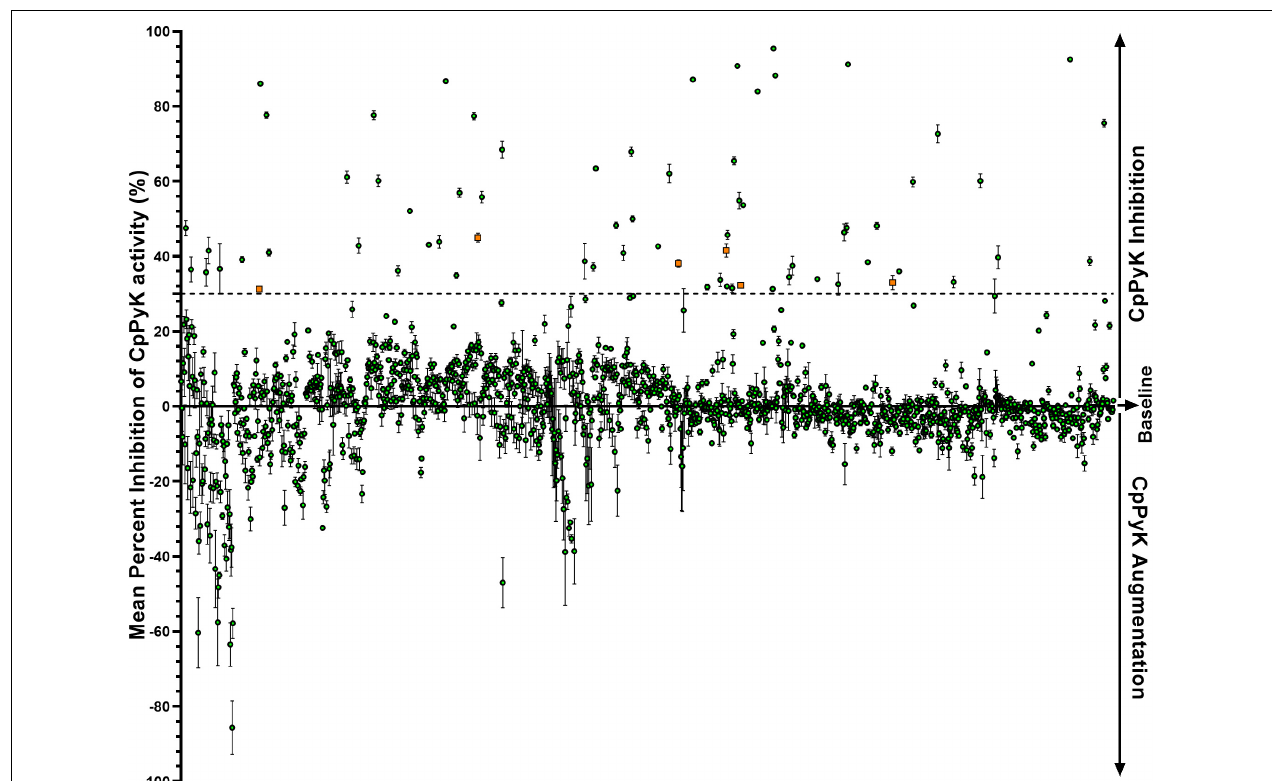
FIGURE 2 | Effect of compounds from the NCI Diversity Set VI chemical library on the catalytic activity of rCpPyK protein. Individually reconstituted compounds were used at a final concentration of 50 µ M in the CpPyK catalyzed reaction for the transfer of a phosphate group from phosphoenolpyruvate to ADP, yielding pyruvate and ATP. The mean percent inhibition of rCpPyK activity by each compound was derived by dividing the difference in luminescence between the compound-treated wells and the DMSO-treated wells by the luminescence of the DMSO-treated wells and multiplying the product by 100. The baseline mean percent inhibition of 0 was for the reaction without compound, but with an equivalent volume of DMSO used to reconstitute the compounds. Compounds with mean percent inhibition values greater than 0 were designated as inhibitors of the activity of rCpPyK, while those with mean percent inhibition values less than 0 were classified as augmenters. The orange squares indicate the six top hits found to have significant inhibitory effect on the in vitro growth of C. parvum as shown in Figure 4 . Each reaction was performed in triplicate, and the data shown represent the mean of three independent experiments. Bars represent standard errors of the mean